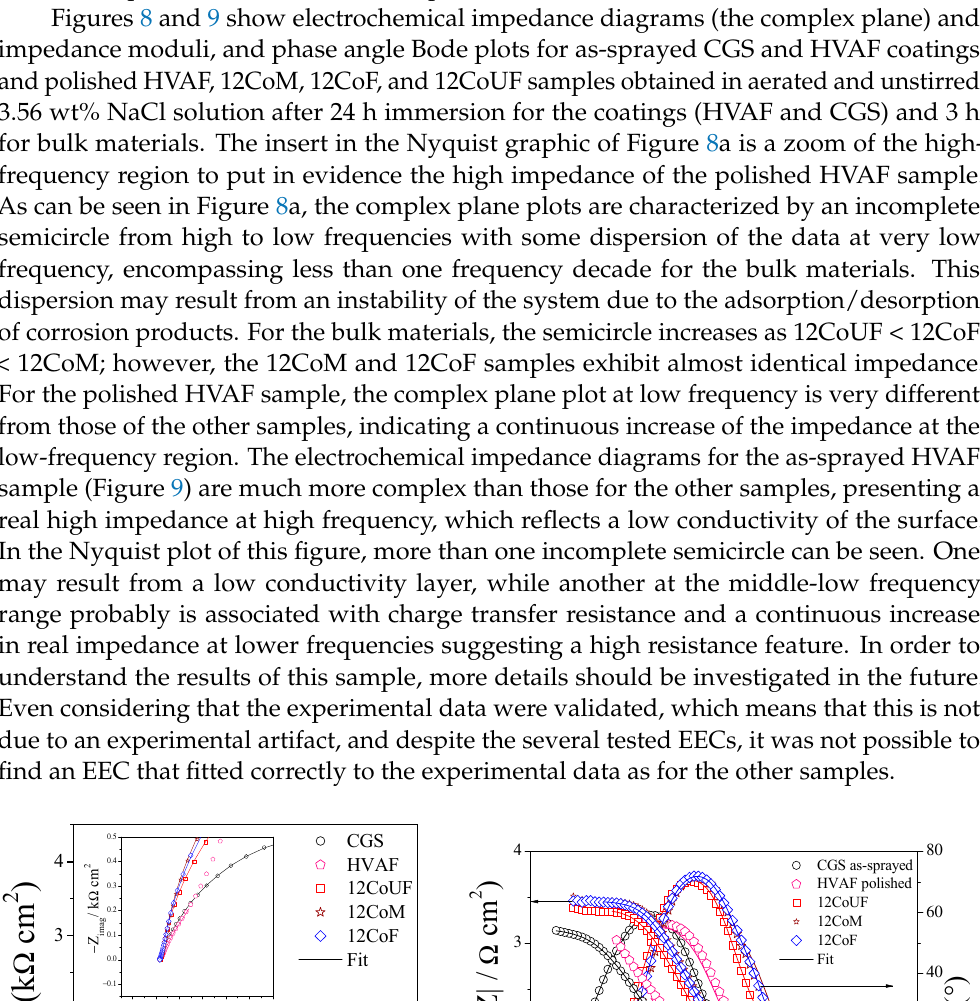
Table 3. Corrosion potential (E corr ) and polarization resistance (R p ) for the different samples in 3.56 wt% NaCl solution at 25 °C.